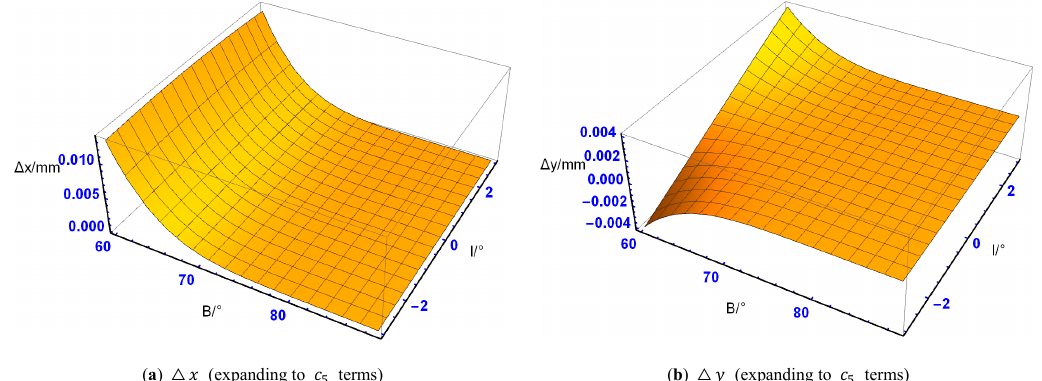
Figure 12. The distribution of ( ∆ x , ∆ y ) when expanding to c 5 terms (based on e ).